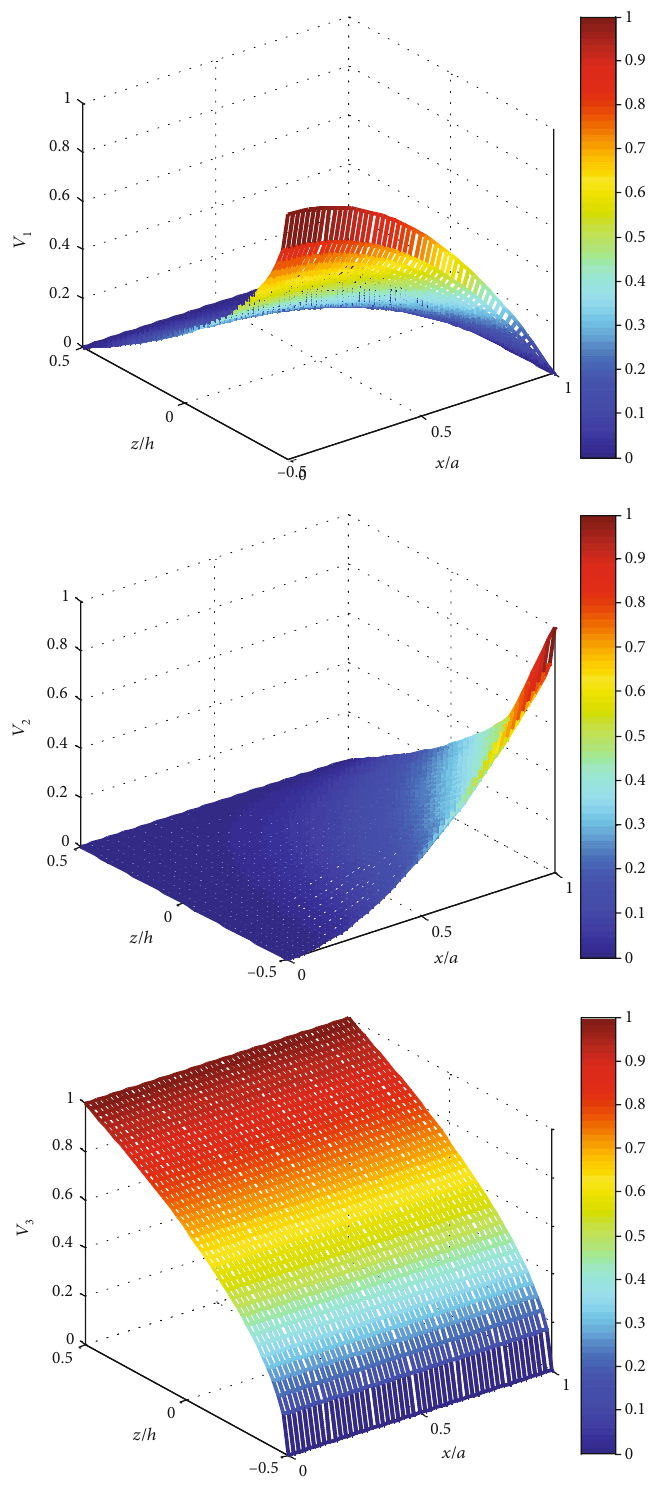
Figure 2: The change of V